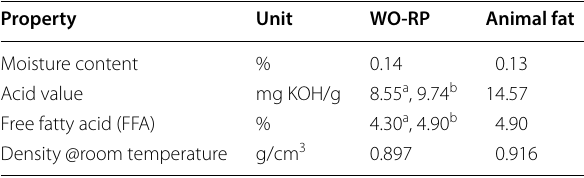
Table 2 Characteristics of waste oil of rendered pork